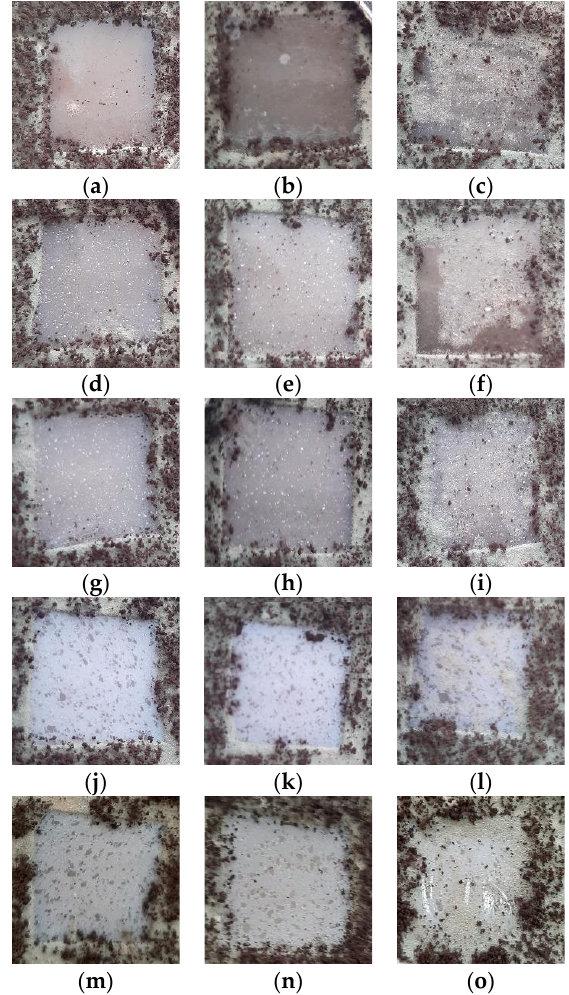
Figure 13. Images of the samples exposed to a fungi mixture after an incubation time of 28 days. Types of samples: ( a , b , c ) LDPE/UHMWPE, ( d , e , f ) LDPE/HAp, ( g , h , i ) LDPE/HAp/RM, ( j , k , l ) LDPE/UHMWPE/HAp, ( m , n , o ) LDPE/UHMWPE/HAp/RM. Irradiation doses: ( a , d , g , j , m ) 0 kGy,